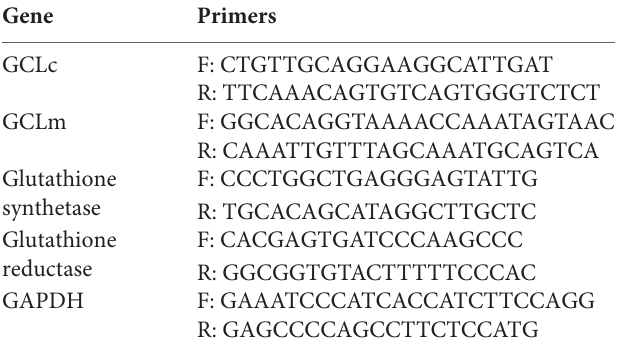
p47phox to bind to NOX2 (Rey et al., 2001; Csanyi et